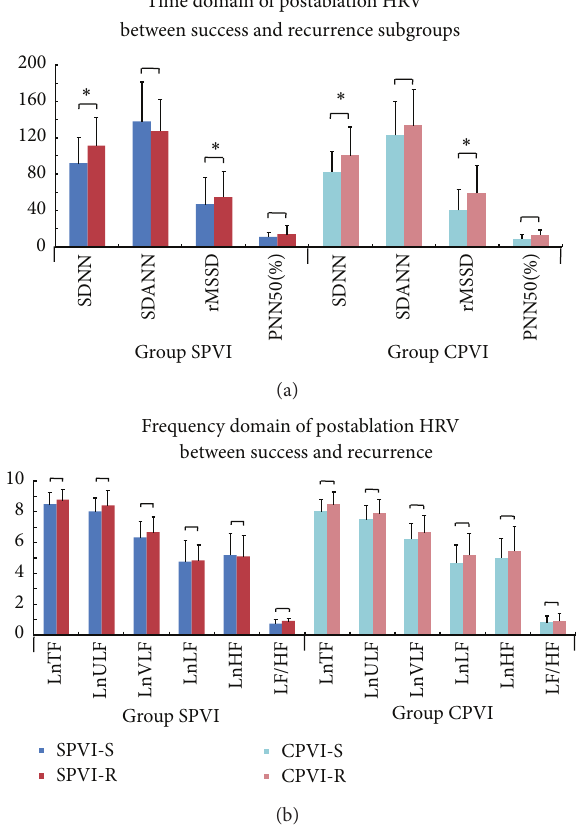
Figure 3: Comparison of postablation HRV between the success and recurrence subgroups. (a) After SPVI or CPVI, SDNN and rMSSD were significantly lower in the success subgroups (SPVI-S and CPVI-S) than in the recurrence subgroups (SPVI-R and CPVI- R). (b) After SPVI or CPVI, there were no significant differences in the frequency-domain parameters of HRV between subgroups (SPVI-S versus SPVI-R; CPVI-S versus CPVI-R, 𝑃 > 0.05 ). Abbreviations are as in Figure 1. ∗ 𝑃 < 0.05